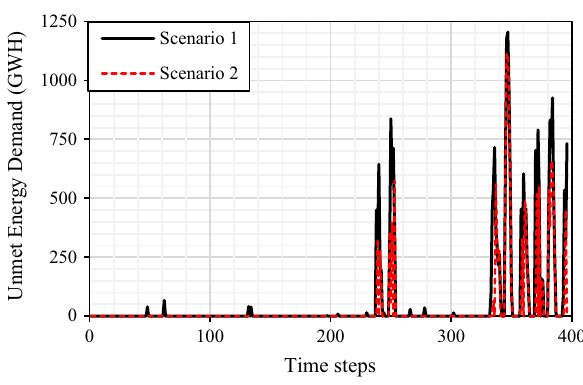
Fig. 6 Unmet energy demand loads the simulation time steps in both